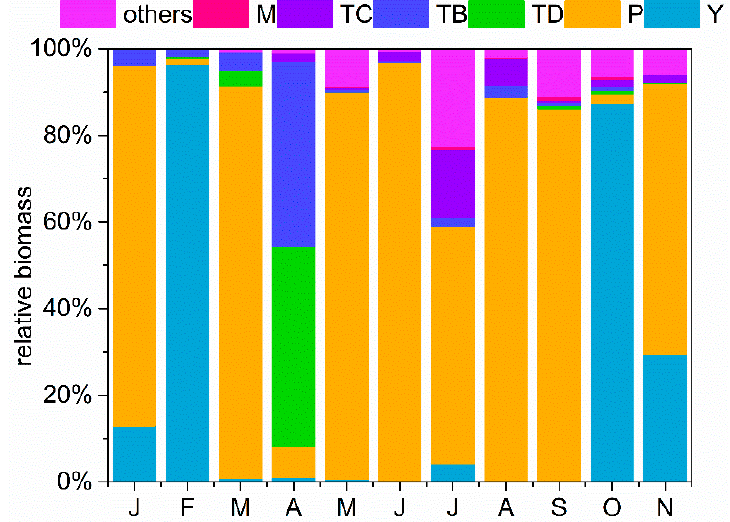
Figure 6. Seasonal variation in relative biomass (%) of the main phytoplankton functional groups inside the reservoir.